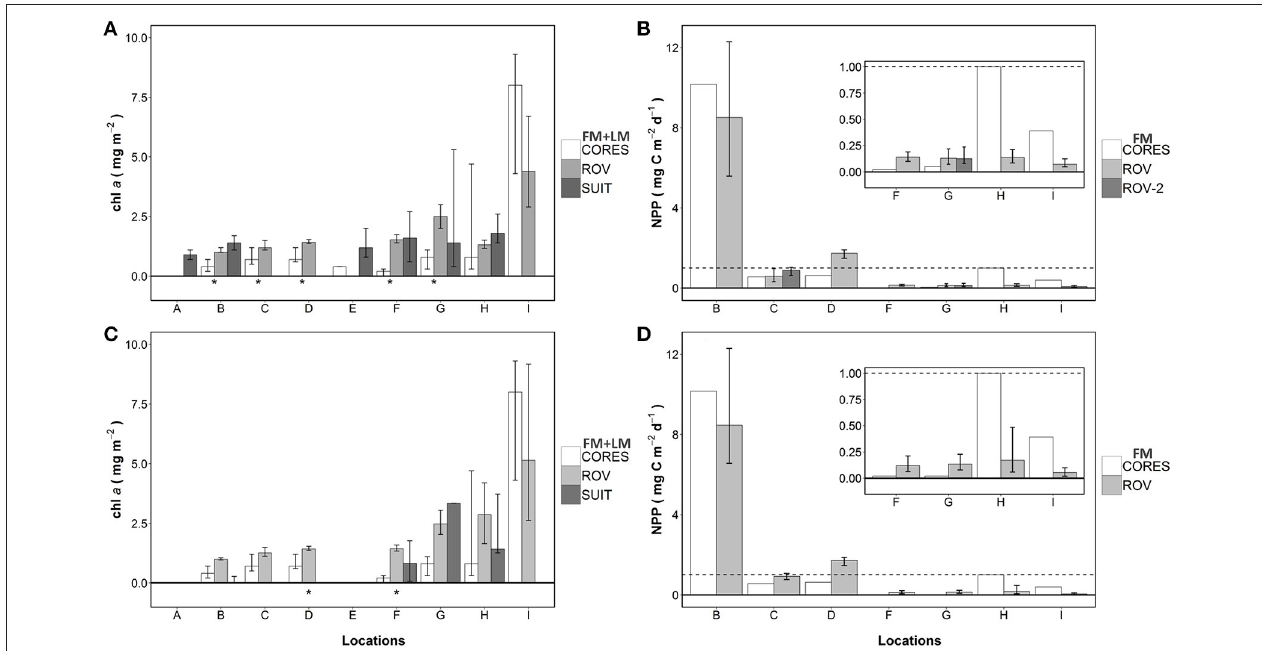
FIGURE 3 | Chl a and NPP summarized per sampling gear and location, and subset into dominant ice classes. (A) chl a biomass for the entire datasets of each sampling gear; (B) NPP for the entire datasets of each sampling gear; (C) chl a estimates from only the dominant ice class; and (D) NPP estimates from only the dominant ice class. Dominant ice classes for each location are listed in Table 3 . Bars represent median and error bars the interquartile range. *Indicates significant Wilcoxon rank sum test at p < 0.05 between the CORES and ROV data for the corresponding location. (A,C) CORES are the combined datasets of FM-CORES, data from Fernández-Méndez et al. (2015); LA-CORES, data from Lange et al. (2016). (B,D) CORES are only the